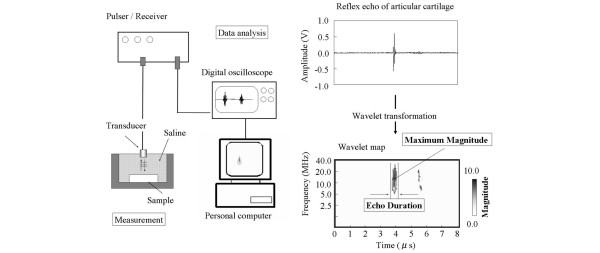
Schematic illustration of articular cartilage analysis and measurement methods of cartilage samples used in [13]. A reflex echo of articular cartilage (upper) and a wavelet map (lower) are shown on the right. The maximum magnitude is indicated by the gray scale and the percentage maximum magnitude (the maximum magnitude of the measurement area divided by that of the intact cartilage of the nonoperated knee; %MM) is used as a quantitative index of cartilage regeneration.